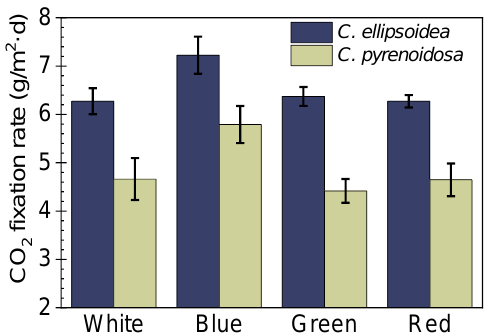
Figure 6. The CO 2 fixation rate for C. ellipsoidea and C. pyrenoidosa cultured under different LEDs. 225